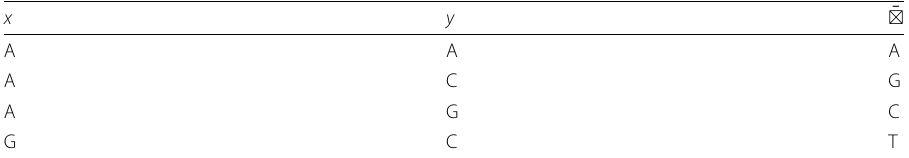
Table 4 The nucleotide operation ¯ (cid:2)